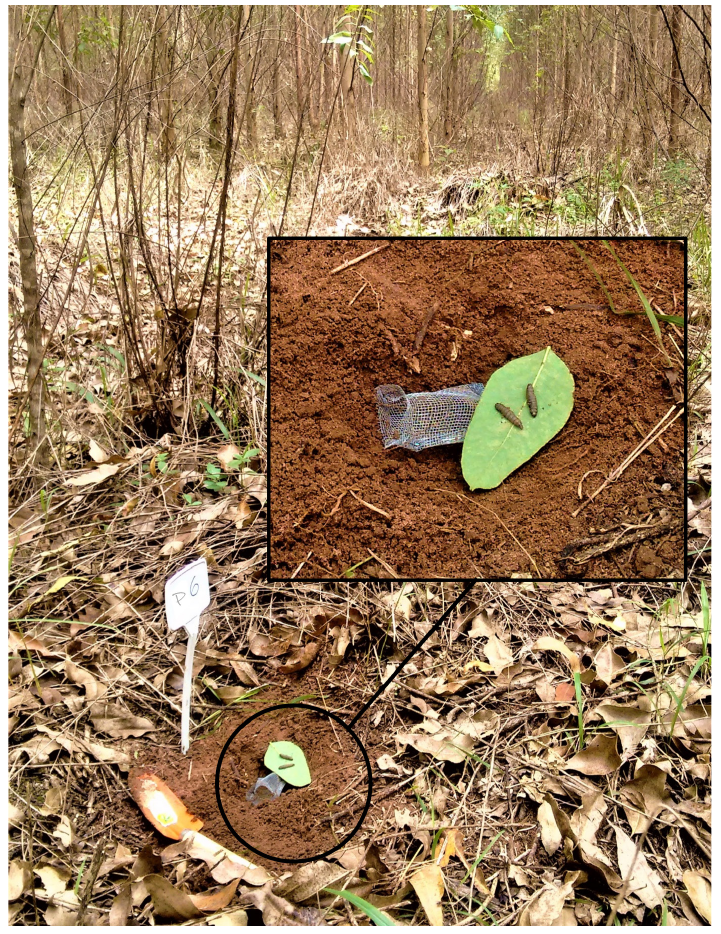
Figure 1. Dead Galleria mellonella larvae collected with steel mesh trap showing symptoms of entomopathogenic nematode